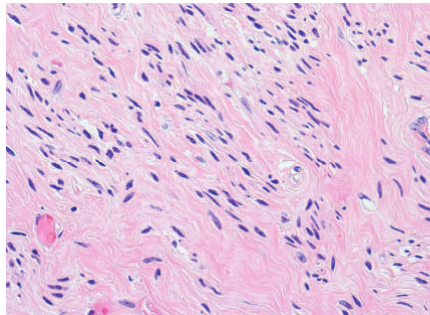
Figure3:Sectionsfromlargeandsmallnodulesfindsmoothmuscle fascicles (H&E 400x).